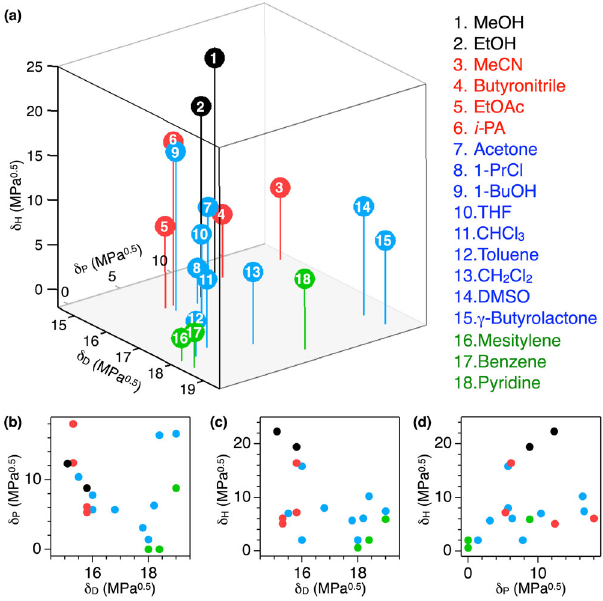
Fig. 4 Hansen space for polymorphs of Py 6 Mes. a Hansen space showing the polymorphism of Py 6 Mes . The solvents that poorly dissolve Py 6 Mes , and that afford porous crystals are respectively colored in black and red. The components of Py 6 Mes are colored in green. The other solvents are colored in blue. b – d The projections of the Hansen space onto the δ D δ P - ( b ), δ δ δ δ D H - ( c ), and P H -planes ( d